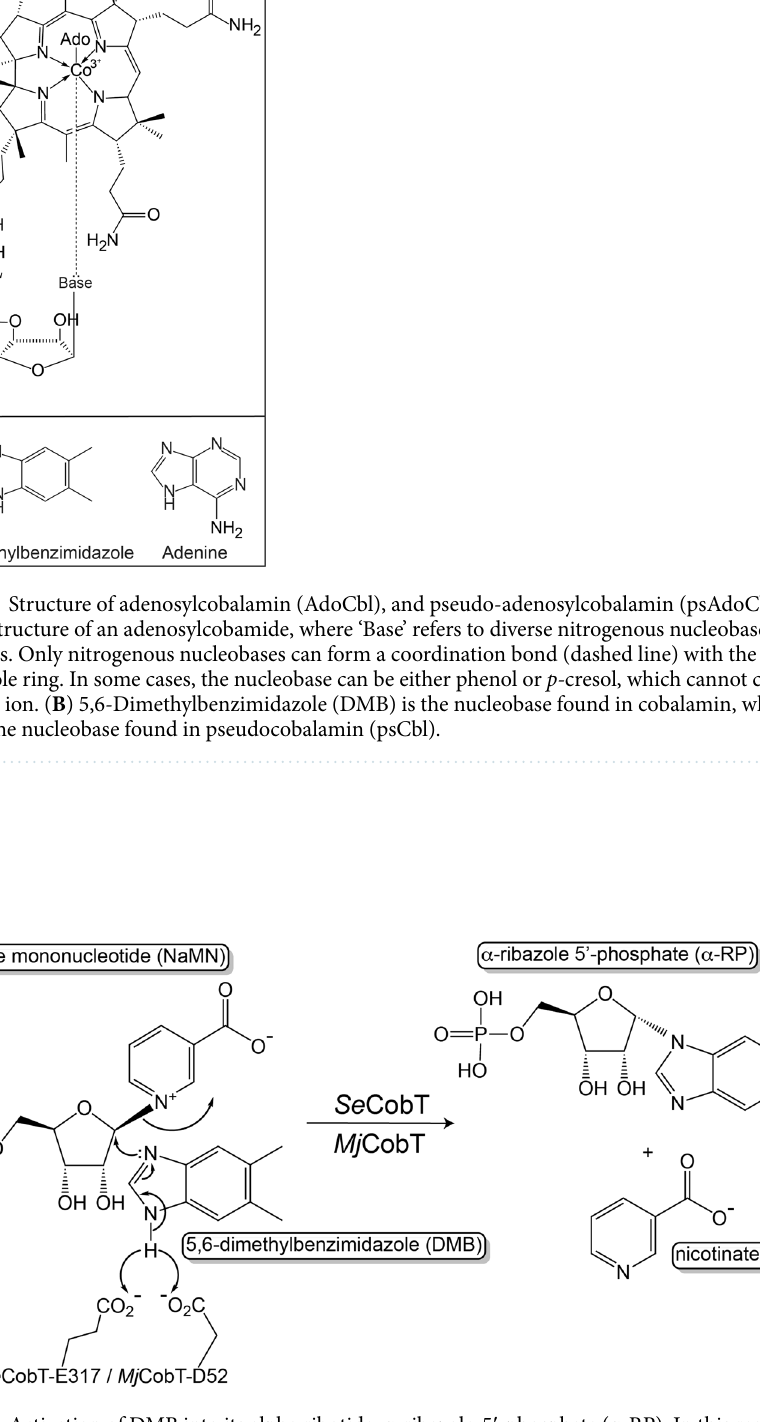
Figure 2. Activation of DMB into its alpha ribotide, α-ribazole-5 ′ -phosphate (α-RP). In this reaction mechanism, residues E317 of Se CobT and D52 of Mj CobT act as general bases to trigger the attack by an unpaired set of electrons of one of the imidazole nitrogens on the alpha face of the molecule resulting in a release of nicotinate and the formation of α-RP, a bona fide intermediate of the nucleotide loop assembly pathway 12,13